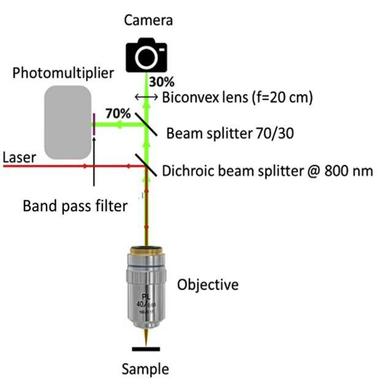
Layout of the non-linear optical microscope used for MPEF measurements.